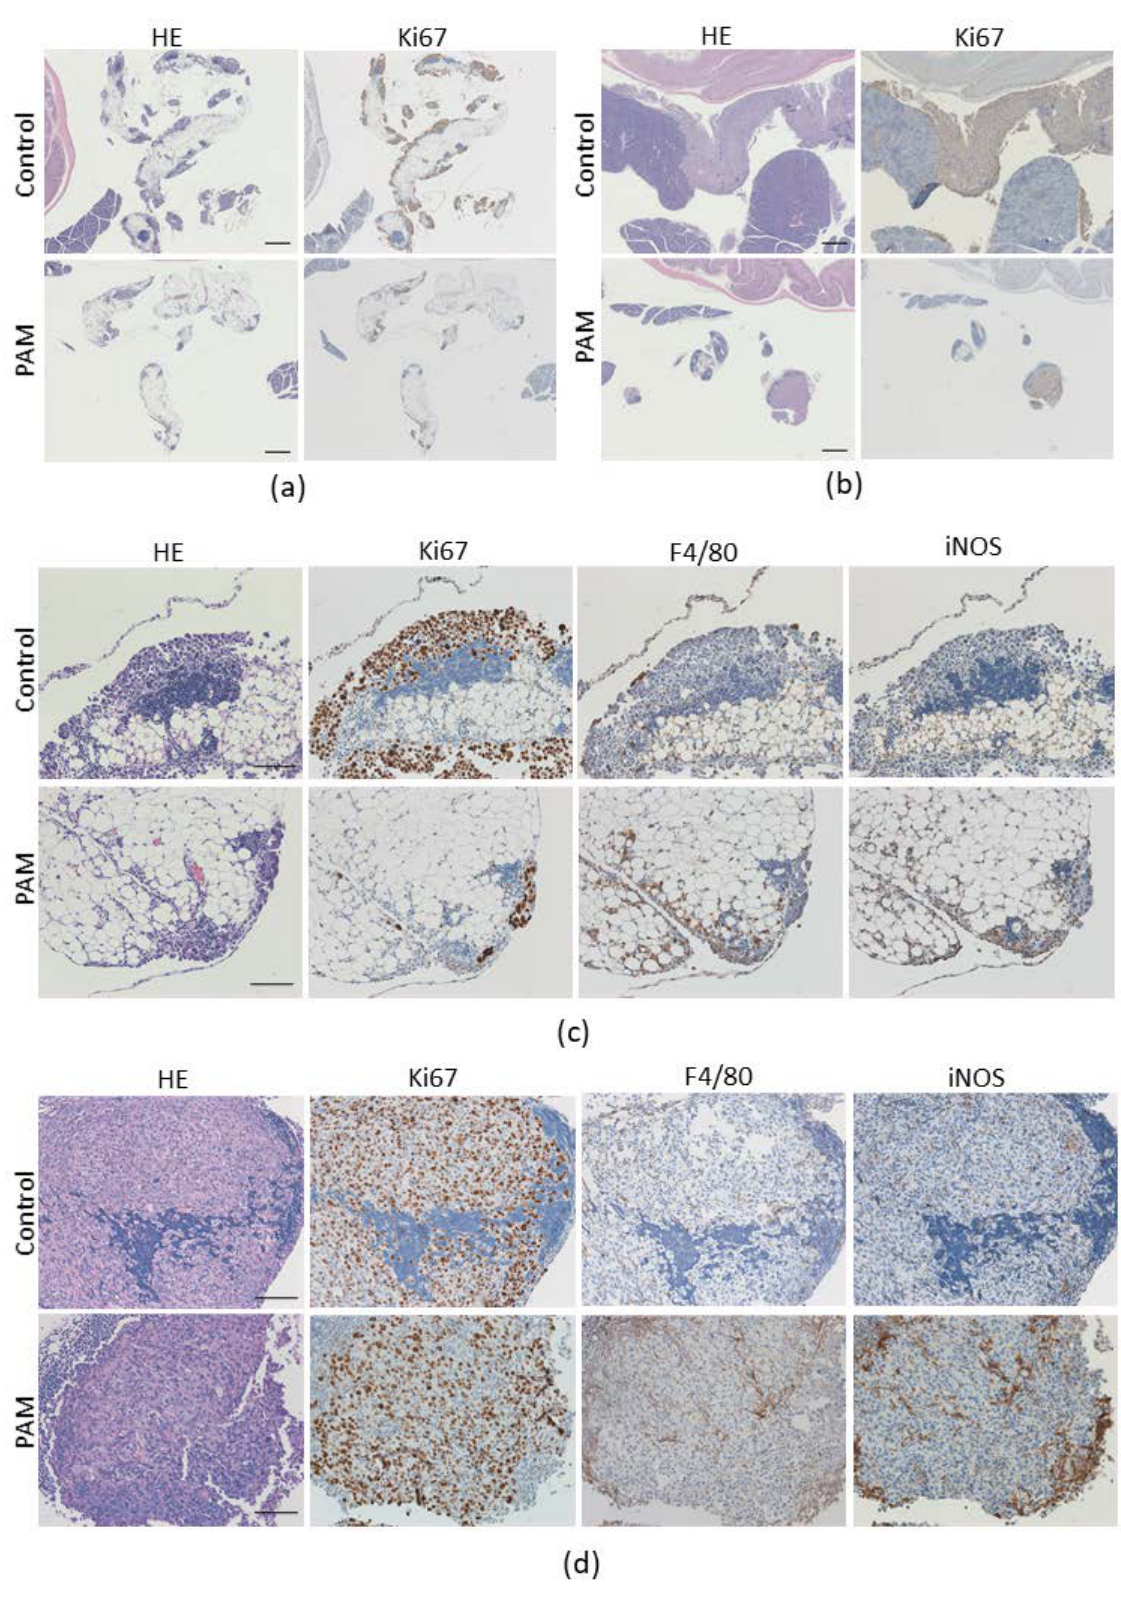
Figure 4. Antimetastatic and proliferative effect of PAM on mouse omentum tissue. The sections corresponding with circled tissues in Figure 3c were used for the indicated immunohistochemical staining as follows: ( a ) Hematoxylin-eosin (HE) and Ki-67 staining on day 3 and ( b ) day 15, ( c ) HE, Ki-67, F4/80 as a macrophage marker, and iNOS staining on day 3 and ( d ) day 15. The scale bars in ( a , b ) correspond to 500 nm and the scale bars in ( c , d ) correspond to 100 nm, in 25 × and 200 × magnification images,